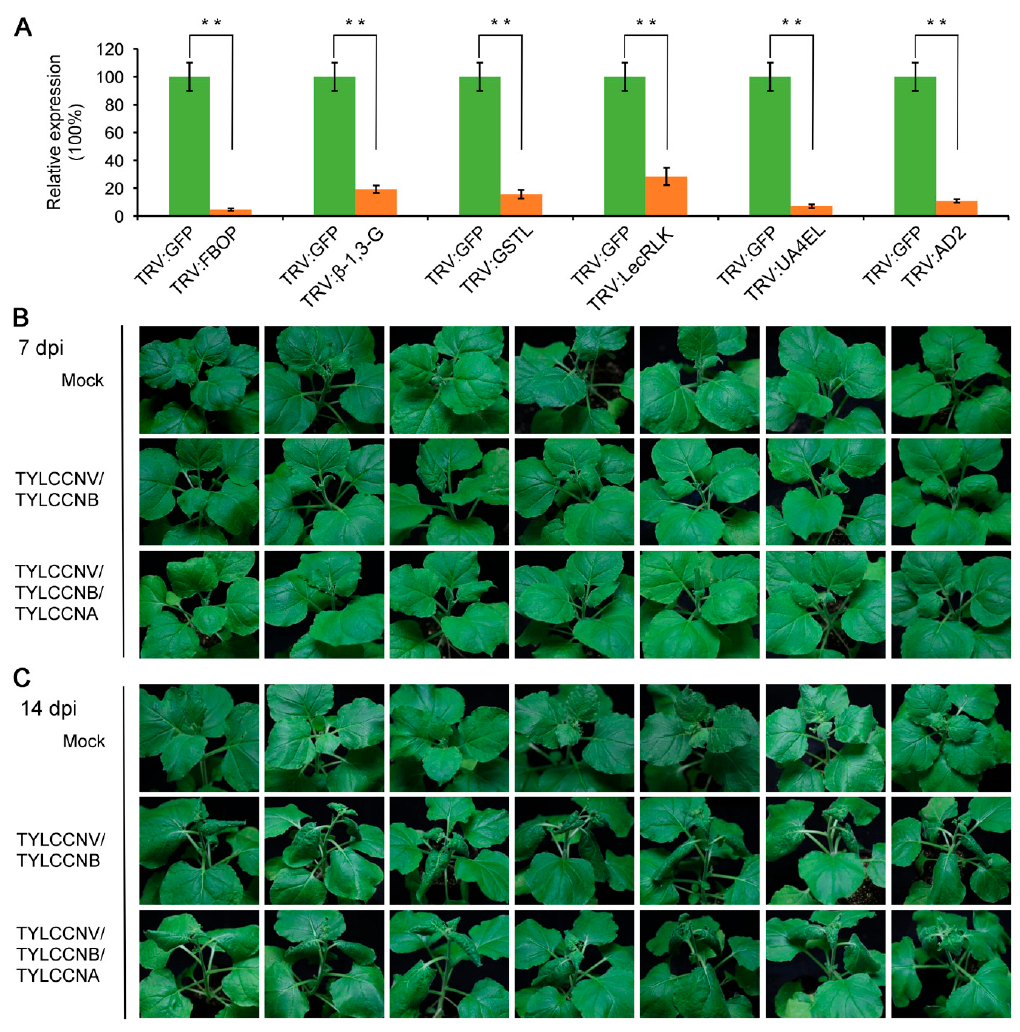
Figure 7. Disruption of the TYLCCNA responsive genes of N. benthamiana makes it susceptible to TYLCCNV/TYLCCNB infection. ( A ) Silencing efficiency analysis. The efficiency of VIGS was determined by RT-qPCR at 10 dpi. The values represented relative mRNA levels against control groups (TRV:GFP-infiltrated N. benthamiana seedlings), values of which are all set to 100%. The data are shown as means ± standard deviation of three biological replicates. Statistically significant differences in gene expression are indicated with ** ( p < 0.01). ( B , C ) Symptom development in the VIGS-silenced N. benthamiana seedlings infected with TYLCCNV/TYLCCNB or TYLCCNV/TYLCCNB/TYLCCNA at 7 ( B ) and 14 ( C ) dpi. Mock-inoculated with pBINPLUS was used as the control.